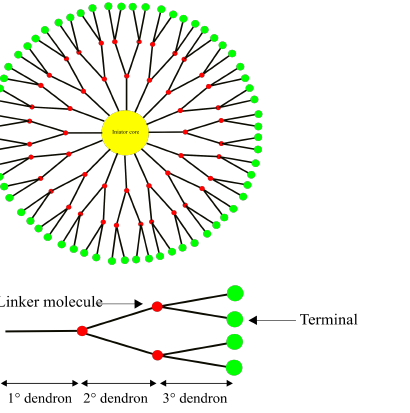
Figure 7. A generic structure of a 3rd generation dendrimer consisting of a core, dendrons and the terminal group. Drugs and functional moieties are typically loaded onto the terminal group.